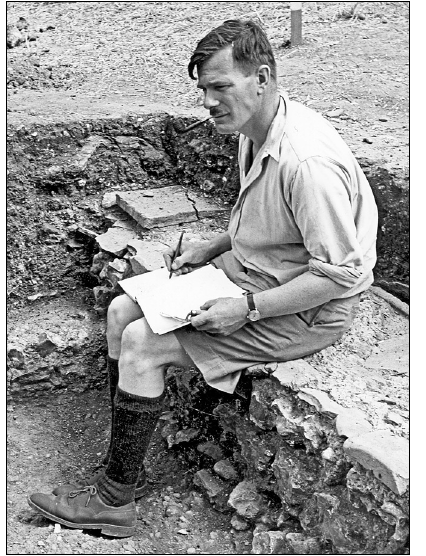
Figure 1 Sheppard Frere on site at Veru- lamium in 1955.